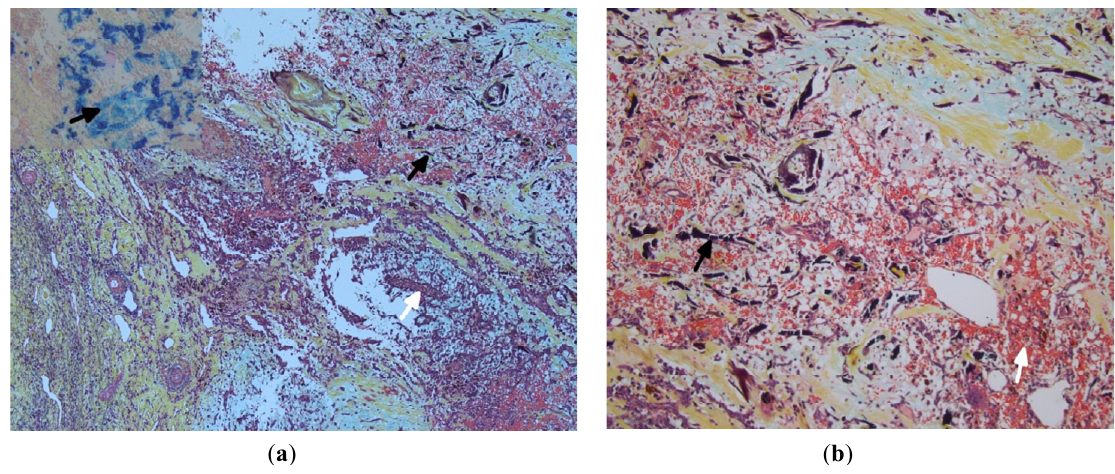
Figure 7. ( a , b ) Sections show Gamna-Gandy bodies (black arrow) and areas of fresh and old hemorrhage (white arrow). Inset shows positive iron stain in the Gamna-Gandy bodies. (Stain ( a , b ): Movat pentachrome; Original magnification: ( a ) ×5; ( b ) ×10).